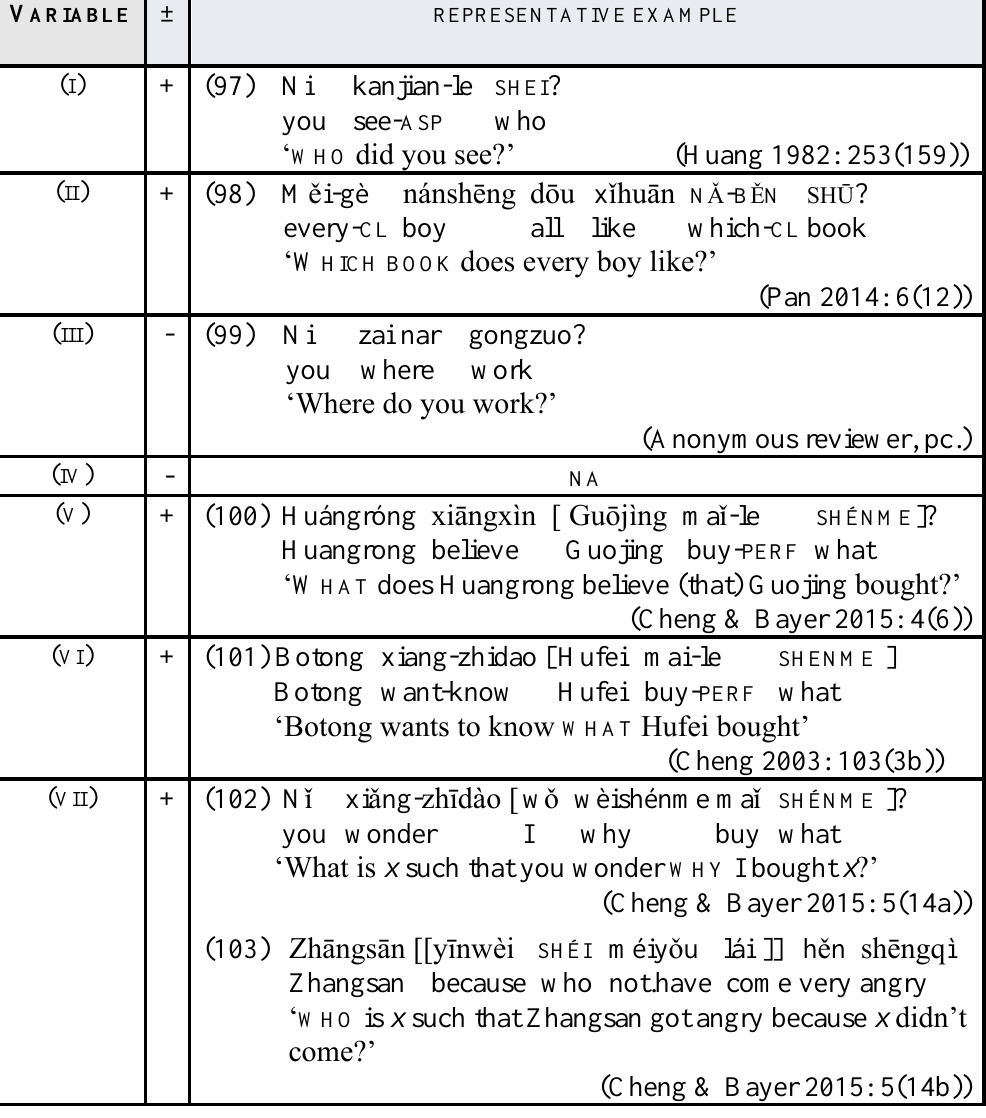
Table 2. Distribution of wh-in situ in present-day Chinese V ARIABLE ± REPRESENTATIVE